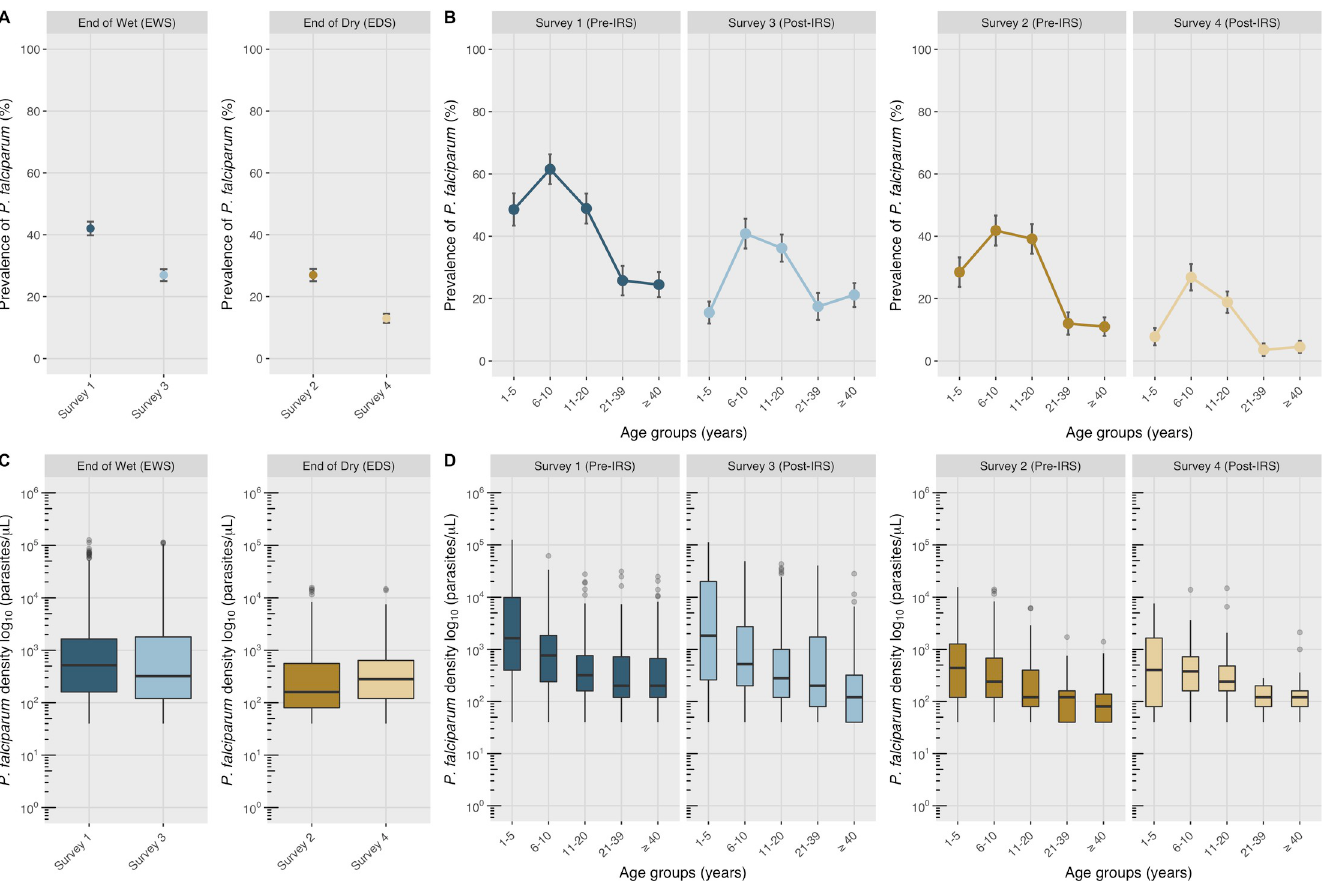
Fig 3. Reductions in the prevalence and density of microscopic P . falciparum infections pre- to post-IRS at the end of the wet (blue) and dry (gold) seasons. Prevalence of microscopic P . falciparum infections pre- to post-IRS at the A. end of the wet and dry season surveys and B. across each age group (years) at the end of the wet and dry season surveys pre- to post-IRS. Error bars represent the upper and lower limits of the 95% confidence interval (CI). Box and whisker plots of the log 10 - transformed microscopic P . falciparum infection densities (parasites/ μ L) pre- to post-IRS at the C. end of the wet and dry season surveys and D. across each age group (years) at the end of the wet and dry season surveys. The boxes represent the inter-quartile ranges (IQR) and the horizontal lines represent the median log 10 - transformed P . falciparum infection densities (parasites/ μ L). The whiskers are used to depict the largest and smallest log 10 -transformed infection densities and the grey dots outside the whiskers are used to denote outliers. The parasite densities were log 10 -transformed to remove skewness. For additional details see S4